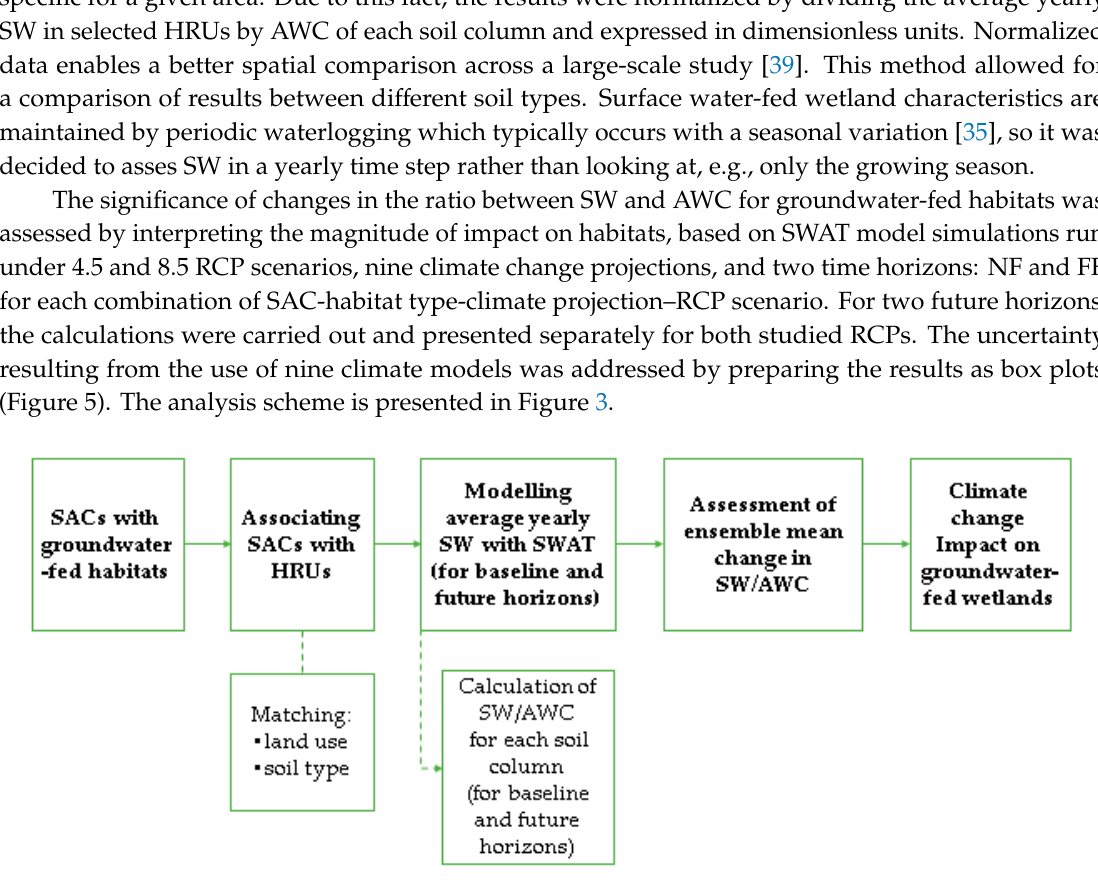
Figure 3. Scheme of the analysis procedure for groundwater-fed wetlands, where SW is soil water and AWC is available water capacity.